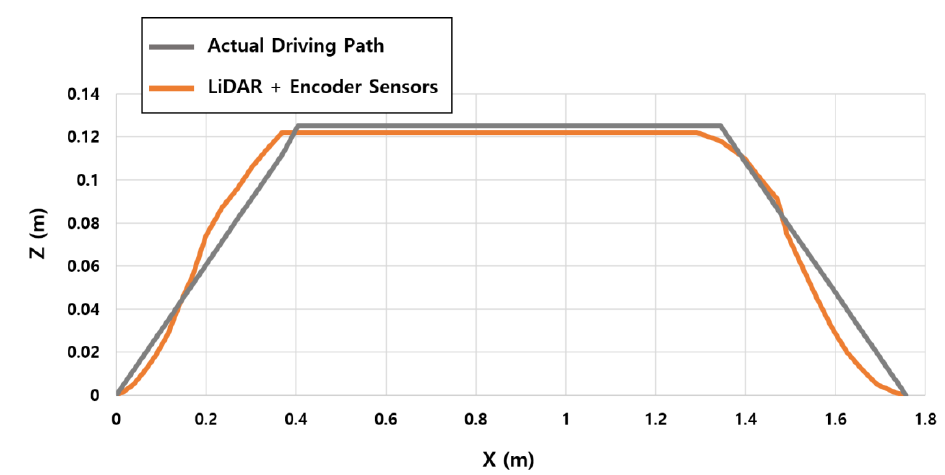
Figure 8. Comparison of the pathways estimated by the IMU + encoder sensors and the actual driving path of the autonomous driving robot in the Z-axis terrain. path of the autonomous driving robot in the Z-axis terrain.